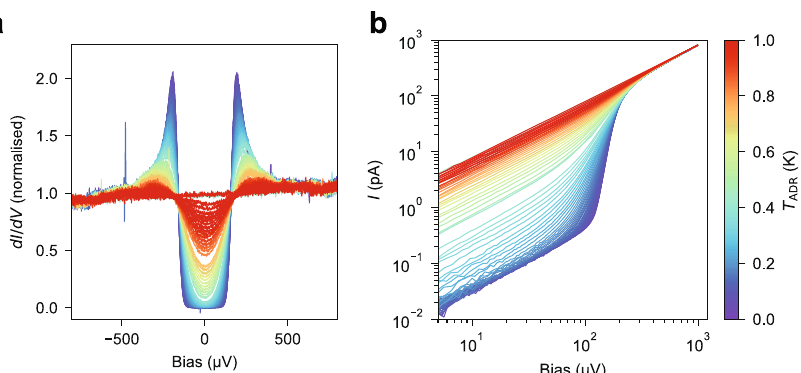
Fig. 9 Dependence of the experimental differential conductance d I /d V and I ( V ) spectra of the normal-metal superconductor tunneling junction on the cryostat temperature T ADR . a d I /d V spectra. b I ( V ) spectra. The data were measured in a fully automatic mode, taking a spectrum every 30 min during approximately 48 h. The noise visible in the d I /d V data comes from the few curves that were affected by small instabilities of the junction, caused by rapid pressure variations in the helium exhaust line.